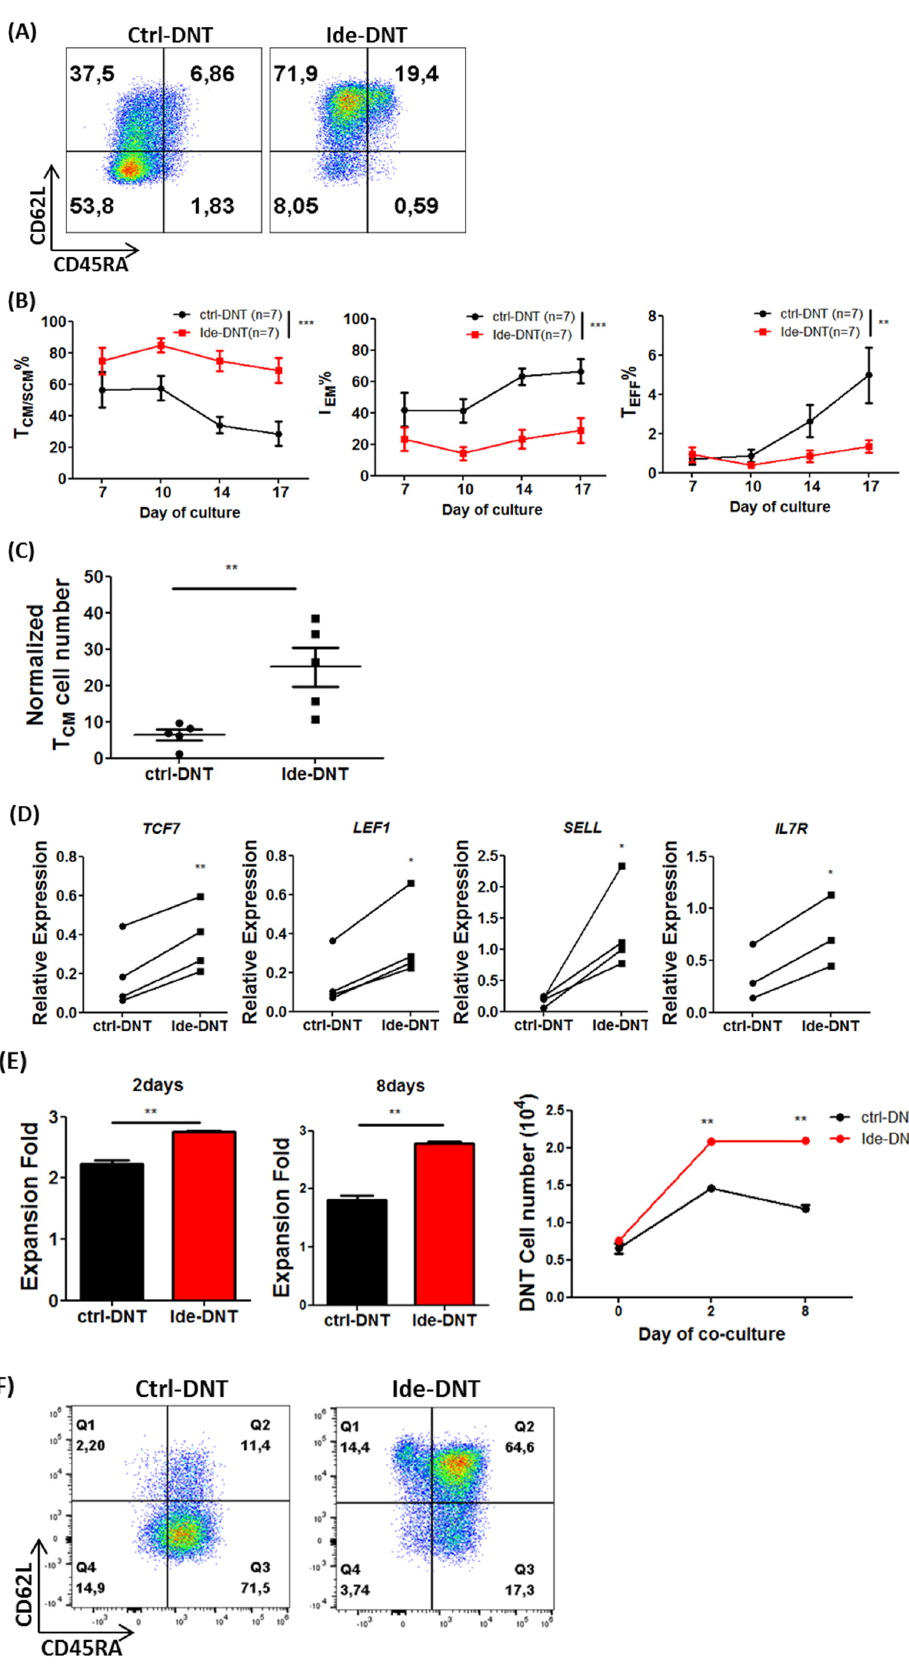
Figure 3. Ide promotes an early memory subset of DNTs that have better proliferative capacity. ( A ) Representative flow plots showing memory status. Memory status of ctrl-DNT and Ide-DNT on day 17 of expansion determined by CD45RA and CD62L expression. T naive/SCM = CD45RA + CD62L + ; T CM = CD45RA − CD62L + ; T EM = CD45RA − CD62L − ; T effector = CD45RA + CD62L − . ( B ) Frequency of DNTs in early memory subset T CM/SCM (CD45RA + /CD62L + and CD45RA − CD62L + ; left), T EM (CD45RA − CD62L − ; middle), and T EFF (CD45RA + CD62L − ; right) from day 7 to day 17 of ex vivo DNT expansion culture. ( C ) T CM/SCM cell number of ctrl-DNT and Ide-DNT on day 17 of ex vivo DNT expansion culture. Each dot represents DNTs from one donor. The cell number is normalized to day 0 DNT number. ( D ) Relative expression of memory associated genes, TCF7, LEF1, SELL, and IL7R , in ctrl-DNT and Ide-DNT determined by qPCR. The expression shown is relative to the expression of housekeeping gene, HPRT . Each of the paired symbols represent DNTs from one donor. ( E ) Expansion of ctrl-DNT (black) and Ide-DNTs (red) in the presence of DNT-susceptible AML cell line, OCI-AML3. Expansion fold relative to the number of DNTs at the start of co-culture was determined after 2 days and 8 days (Left). Absolute number of viable DNTs from each treatment group after co-culture with OCI-AML3 (Right). The results shown are representative of three independent experiments. ( F ) Memory status of DNTs 8 days post co-culture with OCI-AML3 determined by flow cytometry. The result shown is representative of three independent experiments. * p < 0.05, ** p < 0.01, *** p < 0.001 . In addition to genetic and molecular markers, a key biological feature of memory T cells is their ability to persist and proliferate after encountering their targets [33]. Hence, we monitored the proliferative capacity and viable cell counts for Ide-DNTs and ctrl- DNTs during co-culture with an AML cell line, OCI-AML3, for 8 days. We observed a significantly higher degree of proliferation (Figure S7) and number (Figure 3E) of viable DNTs when Ide-DNTs were co-cultured with AML cells than the ctrl-DNT. Importantly, their early memory phenotype was maintained for at least 8 days post co-culture with AML targets, while control DNTs presented a terminally differentiated effector pheno- type (Figure 3F). Collectively, these observations demonstrate that Ide promotes an early memory status of DNTs that may contribute to the superior in vivo leukemia control of Ide-DNT. 3.4. Ide Improves Fitness of DNTs by Inhibiting Exhaustion and Enhancing Viability Next, the effect of Ide on DNT exhaustion was studied as T cell exhaustion can sig- nificantly impair in vivo anti-tumoral activity [30,34]. Ide treatment reduced the expres- sion of inhibitory receptors, Lag3 and Tim3, on DNTs compared to the ctrl-DNTs (Figure 4A and 4B). Furthermore, Ide-DNTs exhibited significantly lower expression of TOX, a transcription factor gene known as the central regulator of T cell exhaustion (Figure 4C). Functionally, Ide-DNTs mediated superior single- (IFNy + or TNF α + ) and multi-cytokine